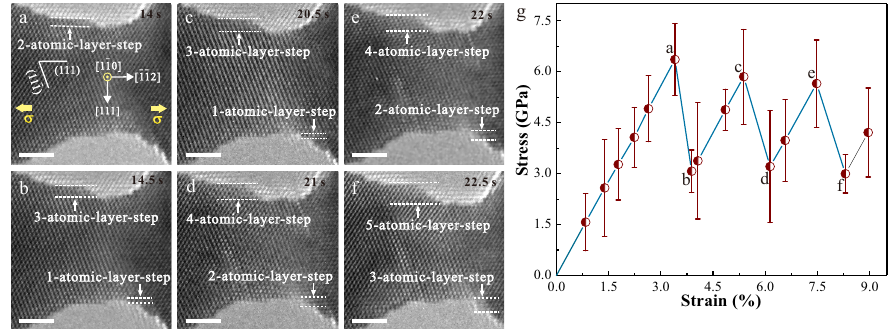
Fig. 3 In situ TEM tensile testing shows pure displacive deformation in a Pt NW. a-f A series of TEM images showing the plastic deformation process of a 5.9-nm-diameter under tensile loading along < 112 > -orientation at room temperature under a strain rate of ~ 10 − 3 s − 1 . The plasticity of Pt NW is controlled by repeated nucleation and emission of full dislocations, and each full dislocation activity resulted in the surface steps thickened by one atomic layer ( b , d , f ). Obvious surface atom diffusion was not observed during tensile loading causing that surface steps remained immobile. All scale bars are 2 nm. g Lattice stress versus applied strain curve during tensile loading; points ( a – f ) indicate the states of deformation shown in the TEM images of a – f . The error bars represent the variations of the measured lattice stresses at different locations of the